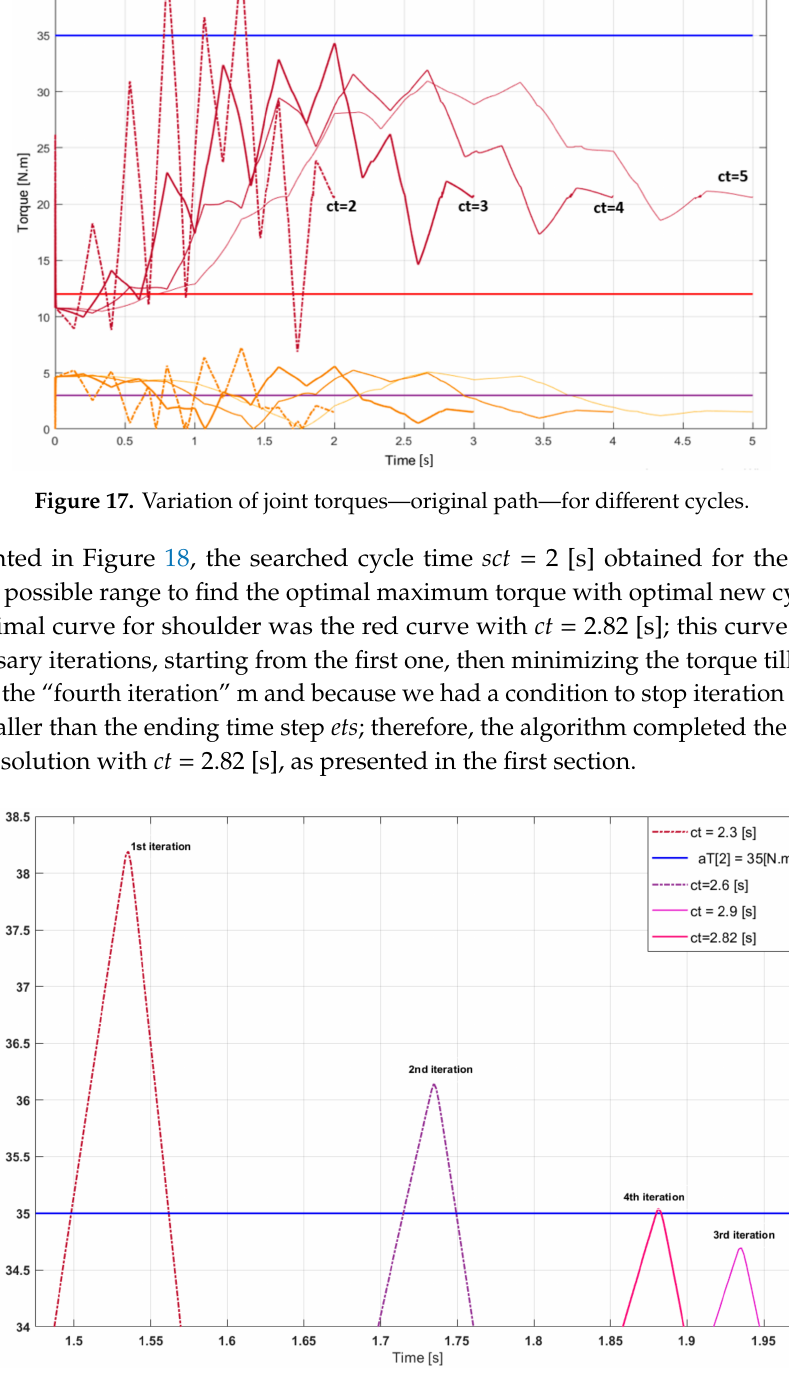
Figure 18. Di ff erent iterations of cycle time minimization algorithm for the original path around the searched cycle time sct = 2